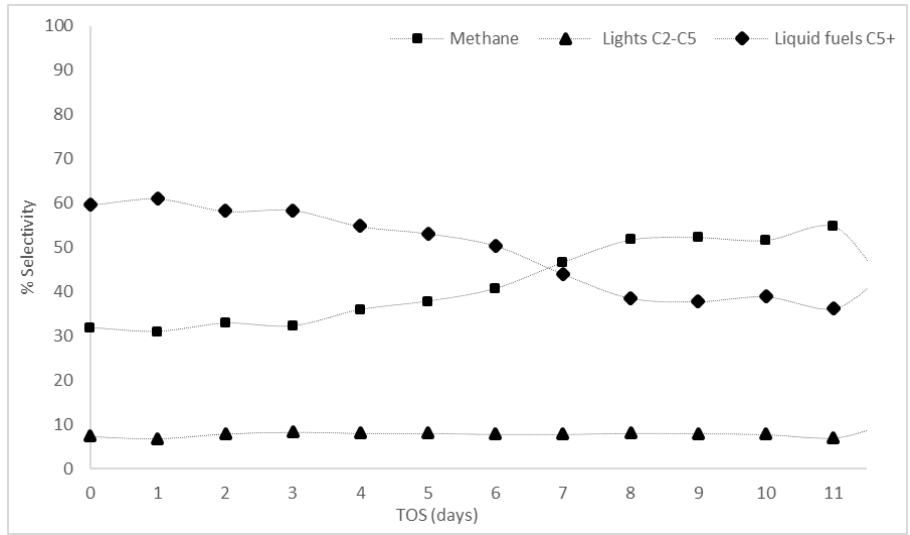
Figure 6. Selectivity for R4 (refer to Tables 3 and 4 for reaction details).